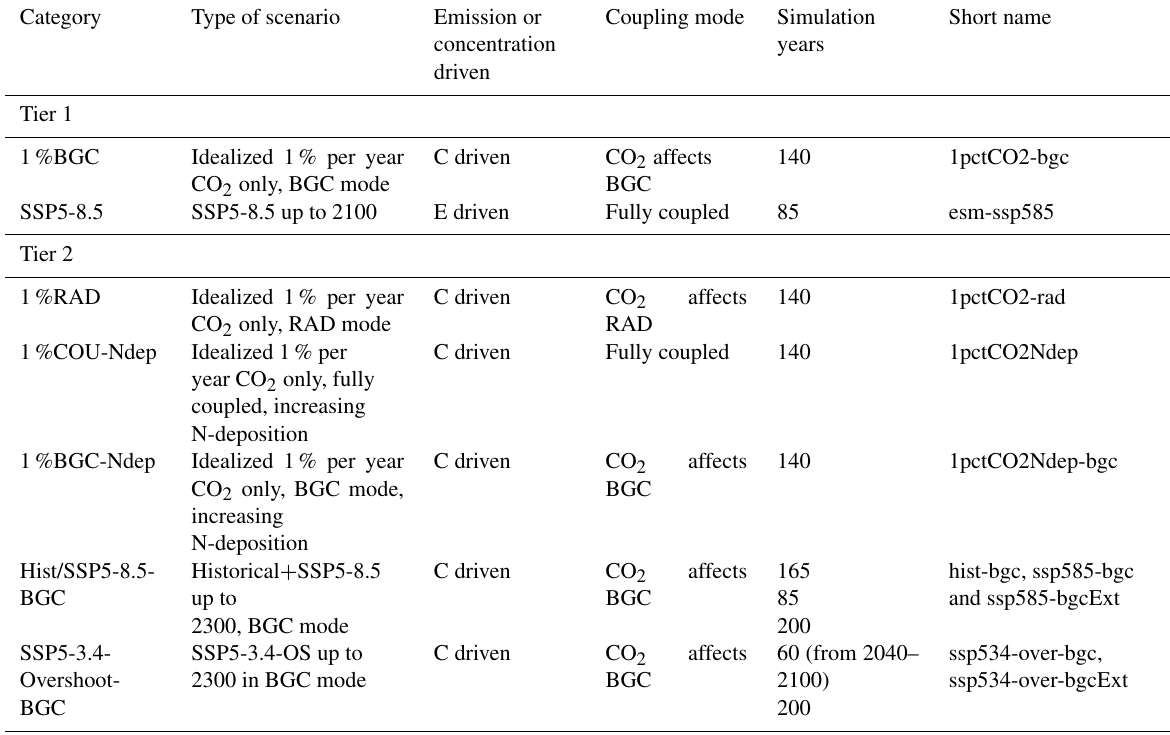
Table 1. Summary of the C4MIP tier-1 and tier-2 simulations. Simulations can be “concentration driven” or “emissions driven” as described in the text. Coupling mode refers to which model components see changes in atmospheric CO 2